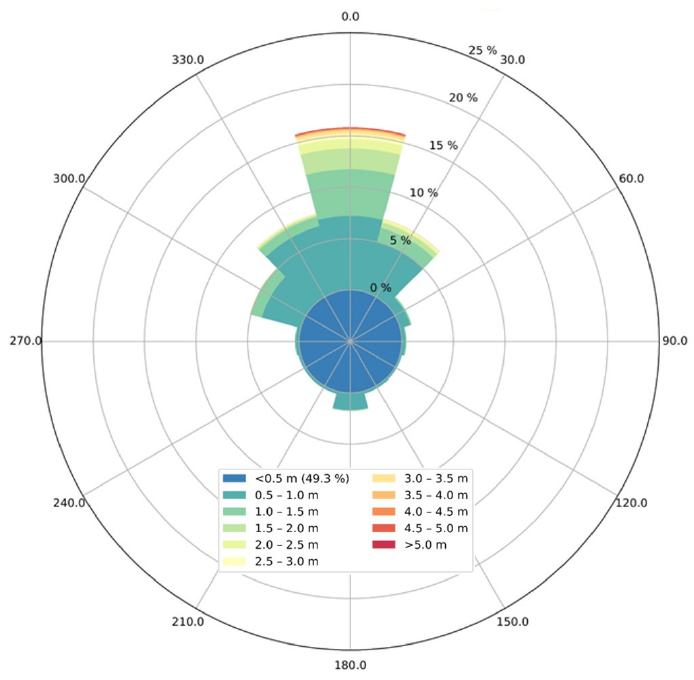
Figure 5. Wave rose plot of the mean annual wave climate offshore the study area of Rethymno.